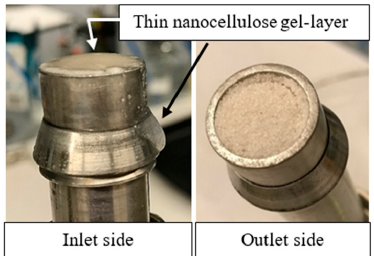
Figure 13. ( Left ) Inlet side of sandpack flooded with 0.5 wt. % CNC (USDA) in 1.0 wt. % NaCl. Thin film of nanocellulose gel sits on the top of the sand. The gel droplet (black arrow) was a result of opening the pack. ( Right ) Outlet side of the same pack after the flood shows no trace of nanocellulose, confirming that filtration prevented transport through the pack.